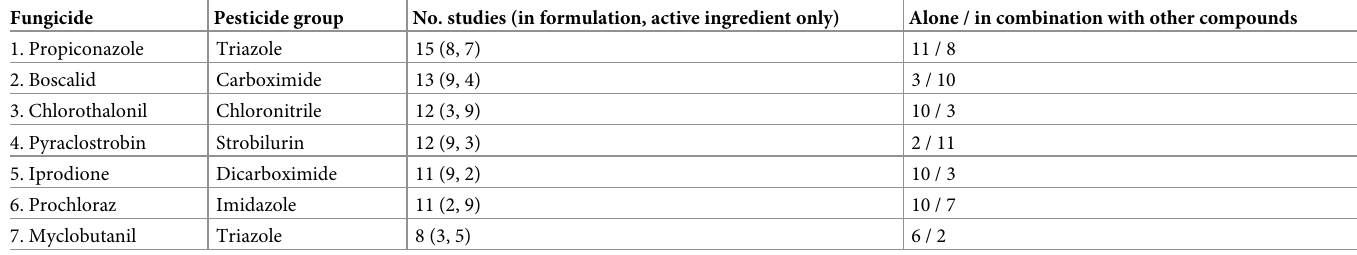
Table 4. The most studied fungicides ranked in descending order, and whether they were studied individually or in combination with other PPPs. The number of studies that used a formulation or analytical grade active ingredient alone, are displayed in parenthesis. Fungicide Pesticide group No. studies (in formulation, active ingredient only) Alone / in combination with other